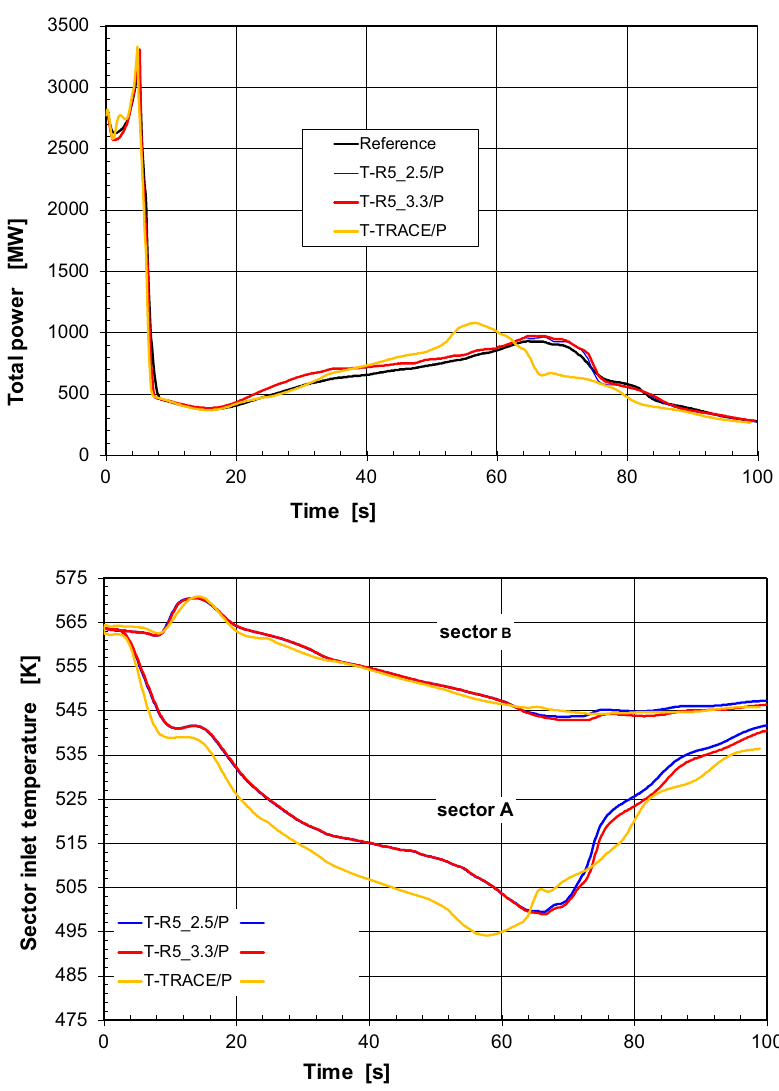
Figure 5. OECD MSLB benchmark exercise 3 transient